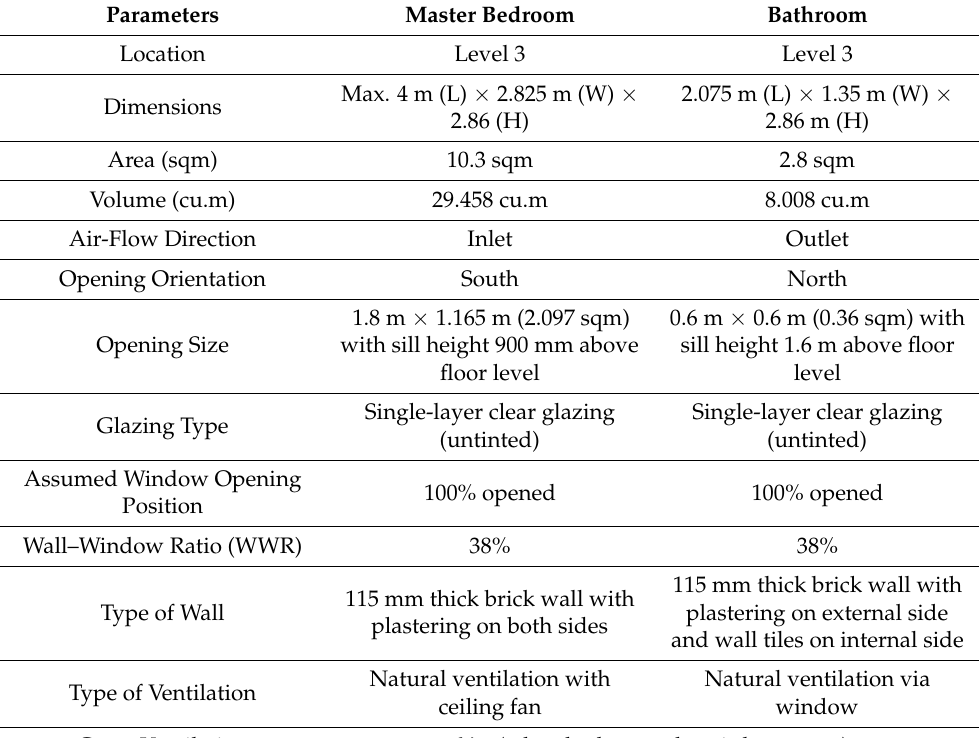
Table 2. Description of the case study room (master bedroom with attached bathroom).